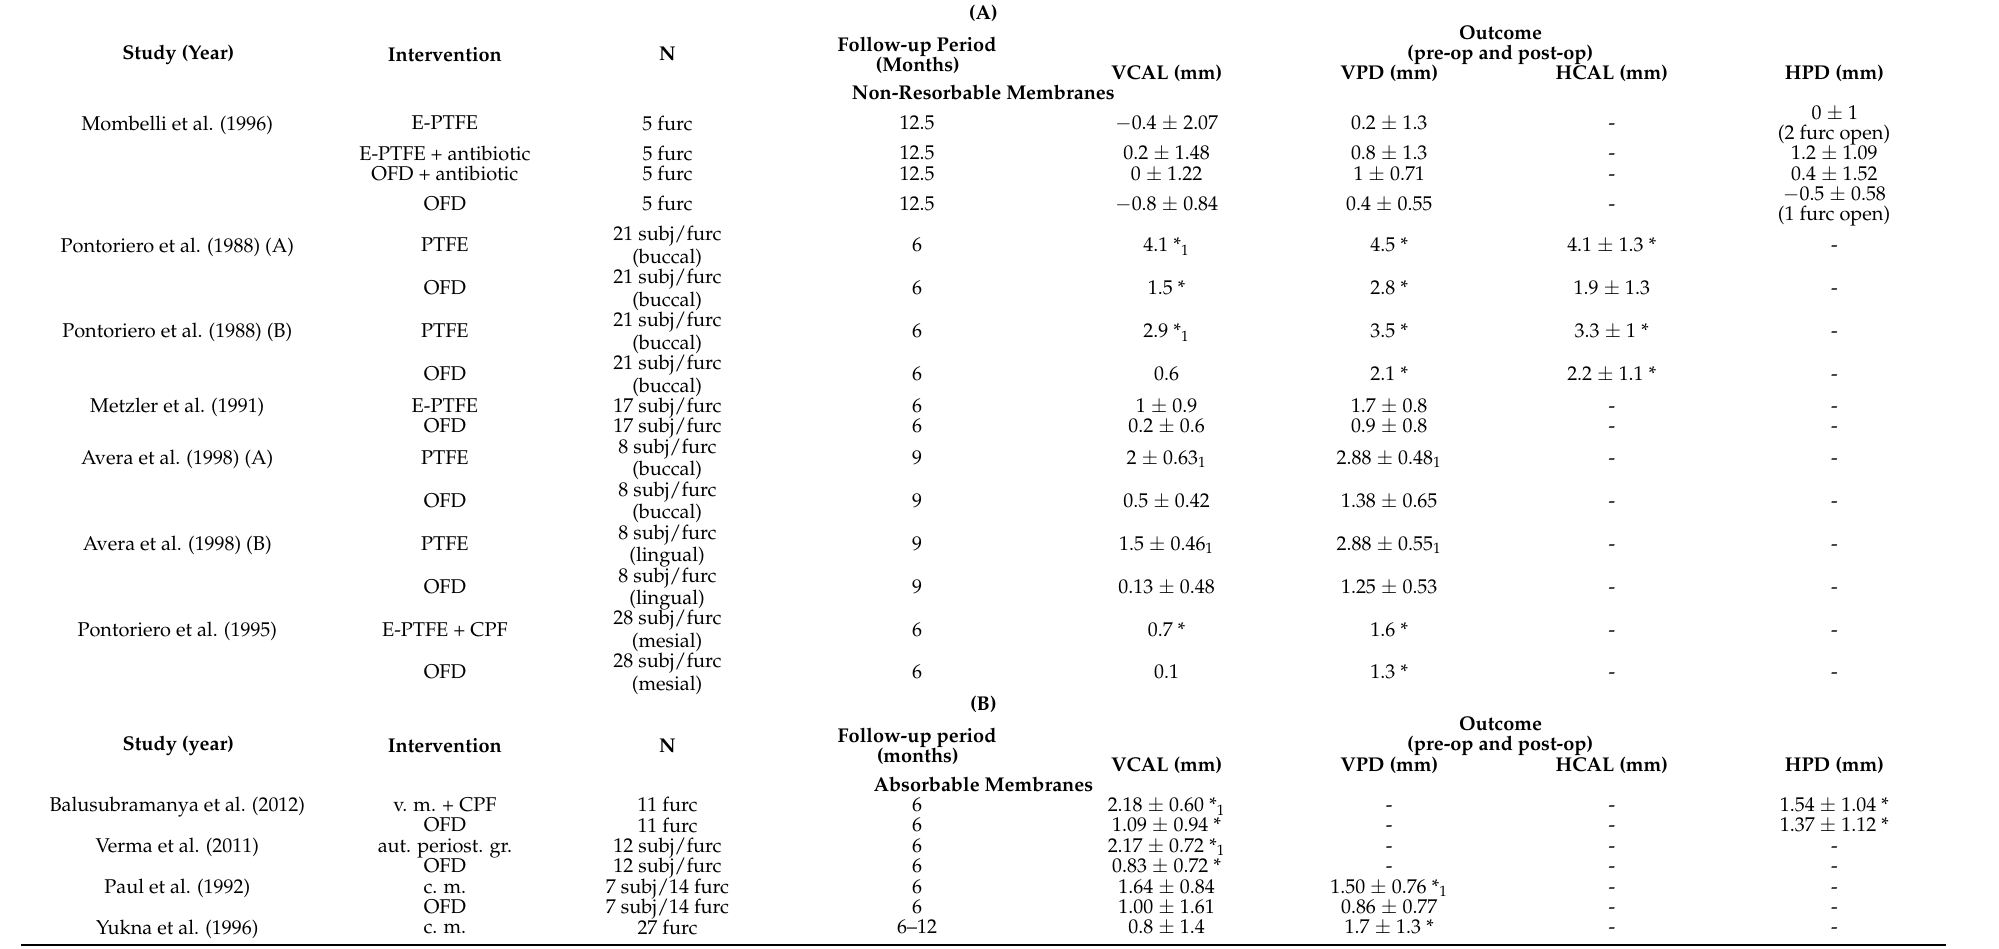
Table 7. (A) Changes reported from baseline and follow-up period in studies where non-resorbable membranes were used. (B) Changes reported from baseline and follow-up period in studies where absorbable membranes were used. (C) Changes reported from baseline and follow-up period in studies where blood derivatives were used. (D) Changes reported from baseline and follow-up period in studies where miscellaneous materials were